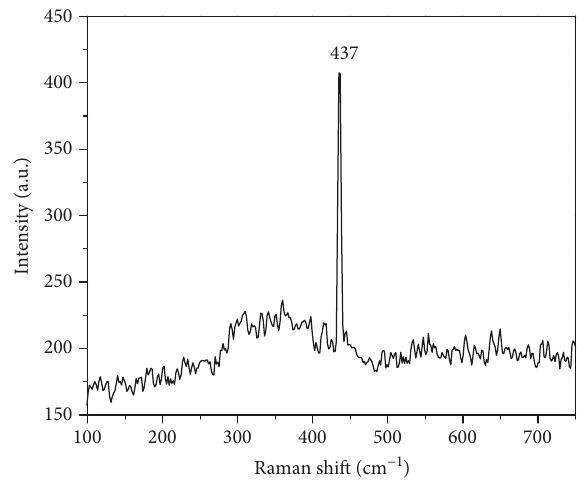
Figure 2: Raman spectra of the AC-ZnO